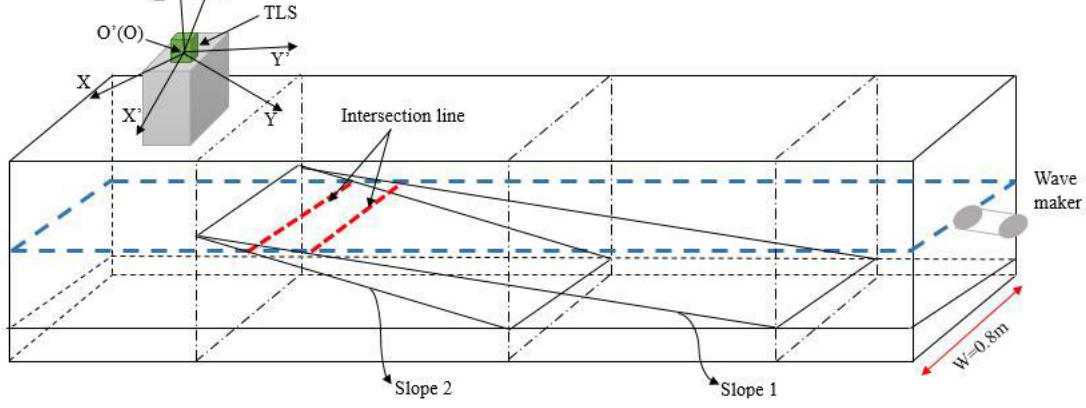
Figure 3. Sketch map showing the test scene observed by laser scanner. The map also indicates the X’Y’Z’ coordinate system